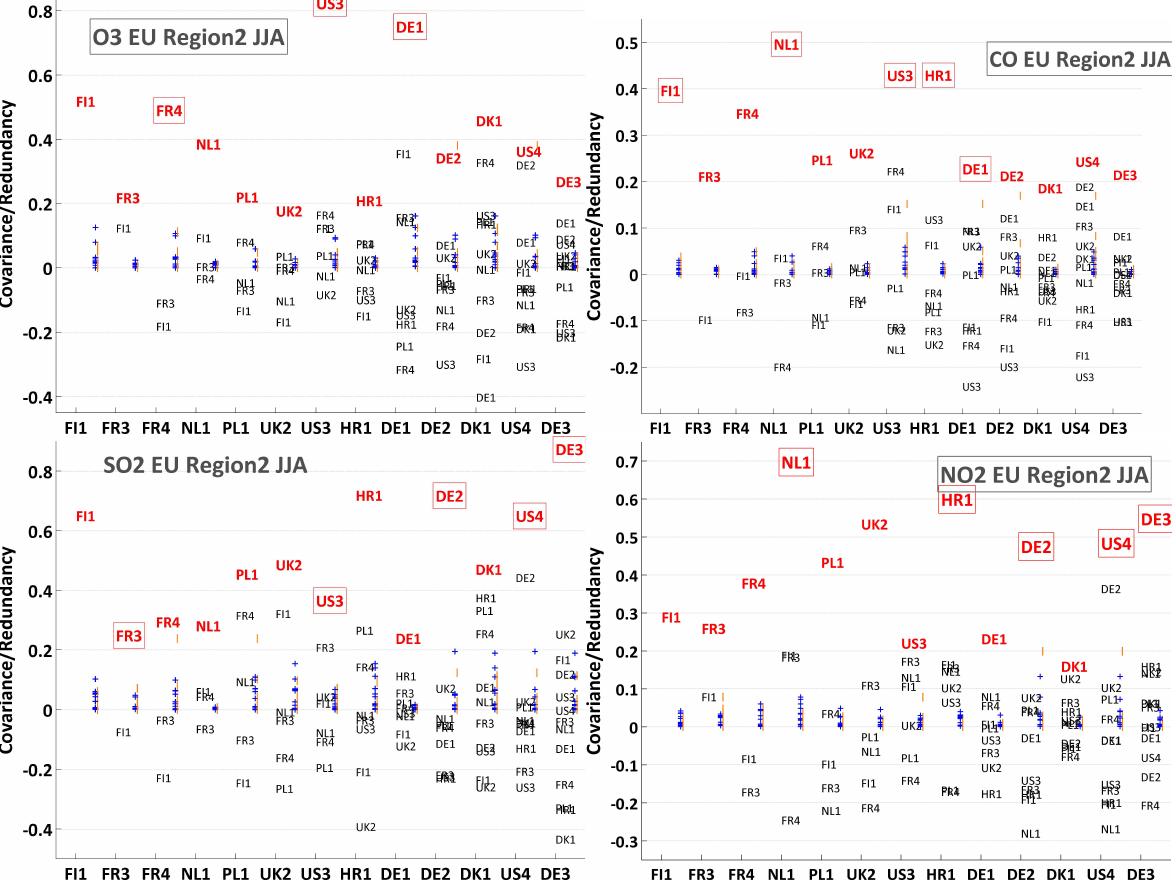
Fig. 3. cov( d i , d j ) by species for European region 2. In red the variance (cov( d i , d j )) , in blue the range of redundancy (corr 2 ( d i , d j )) and in orange the range of redundancy measured by means of the mutual information (see text).The models in the square are those whose ensemble mean produces the minimum MSE (see Sect.